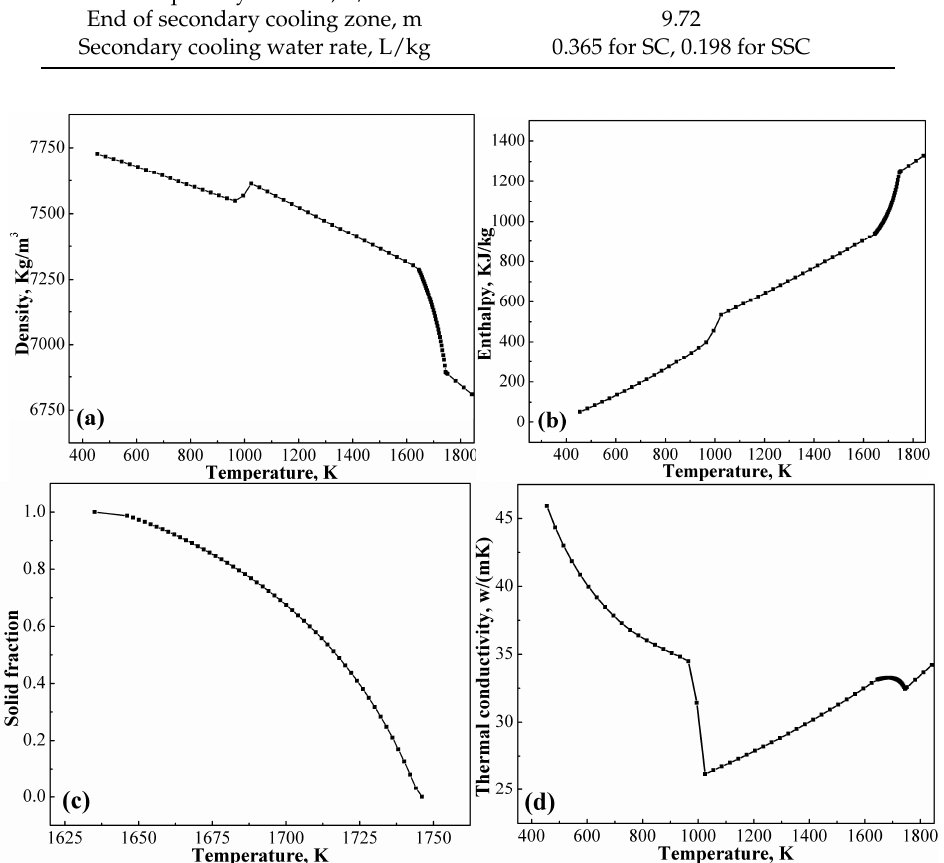
Figure 2. Variations of the thermo-physical parameters with temperature of U71Mn steel: ( a ) density; ( b ) enthalpy; ( c ) solid fraction; ( d ) thermal conductivity.